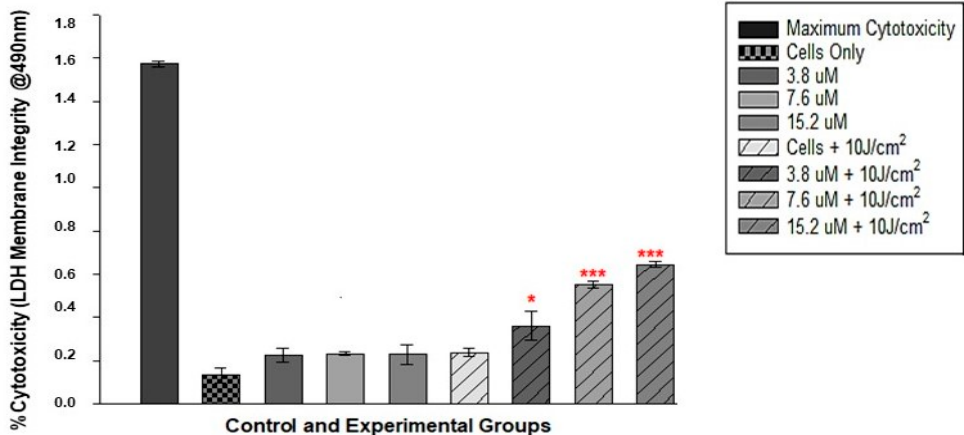
Figure 7 . LDH membrane integrity test results after 12 h incubation post PDT irradiation with a laser fluence of 10 J/cm 2 . Significance is shown as * p < 0.05, *** p < 0.001 (SEM). Experiment was repeated 3 times (n = 3).